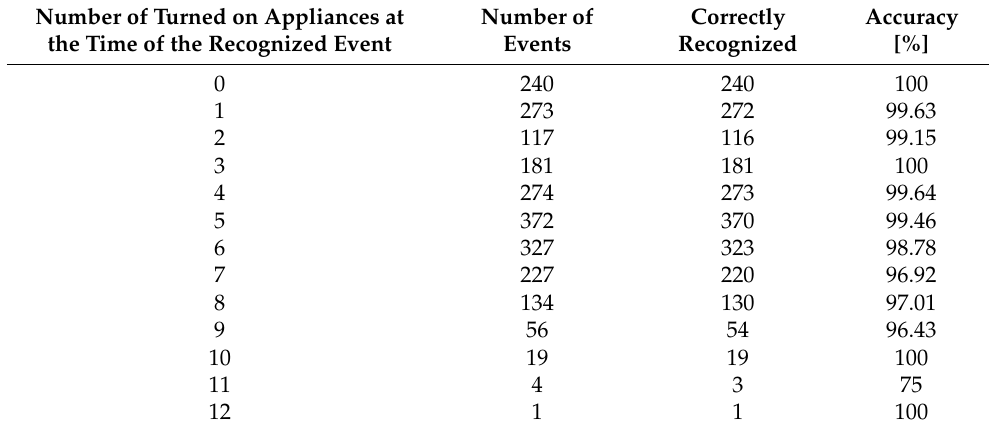
Table 9. Impact of the number of appliances working in the background on identification accuracy.